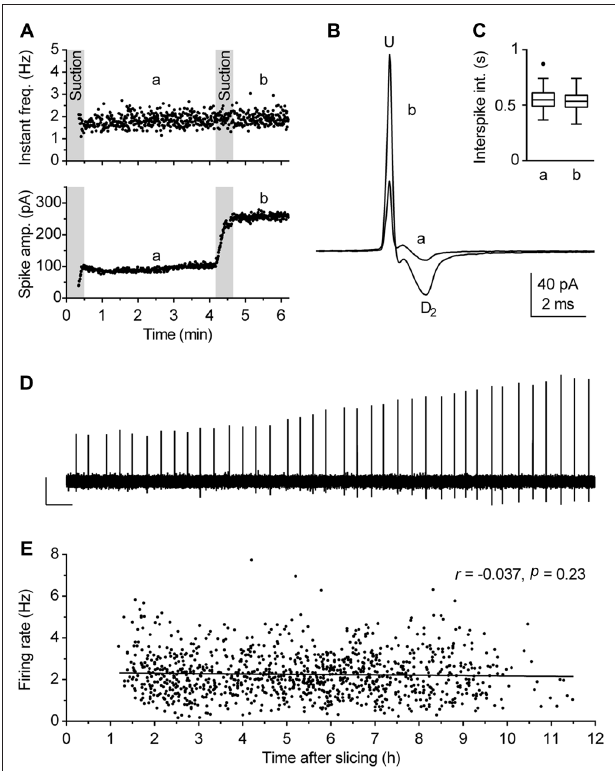
FIGURE 3 | Validity of firing rate measurement by use of loose-seal cell-attached recordings. (A–D) The procedure used to verify the lack of the pipette interference with the measurement. (A) Time-course of a recording illustrating the procedure. During the first 30 s, gentle suction was applied to the pipette to establish loose-seal cell-attached recording configuration. The pressure was then released and after 30 s, left to allow relaxation of the patched cell membrane, a 3-min-long segment (denoted a, from 1 to 4 min) was acquired for the measurement. Afterward, additional suction was slowly applied until the spike amplitude approximately doubled (lower panel) and the recording was prolonged for an additional 1.5 min (denoted b). Since the firing rate remained essentially the same after the test (second suction), the recording was considered reliable, i.e., free of pipette interference. (B) Superimposed average spikes of the same experiment. Spike duration, measured as the interval from the upstroke peak (U) to the second downstroke peak (D 2 ), was unchanged by the additional suction. (C) Box plot of the same experiments shows no changes in distribution of interspike intervals (ISI). Boxes represent median and the interquartile range (IQR). Whiskers denote 1.5 IQR. (D) Trace shows a segment (4:10–4:30 min) of the original recording during which additional (test) suction was applied. Scale bars: 50 pA, 1 s. (E) Post hoc analysis performed to verify that firing rate of recorded neurons was not influenced by the time passed between slicing and recording. Symbols represent individual neurons. Pearson correlation revealed no correlation between the time after slicing and the firing rate ( r = − 0.037, 95% CI − 0.096 to 0.023, r 2 = 0.0014, P = 0.23). Lines represent linear regression (Slope − 0.017 Hz h − 1